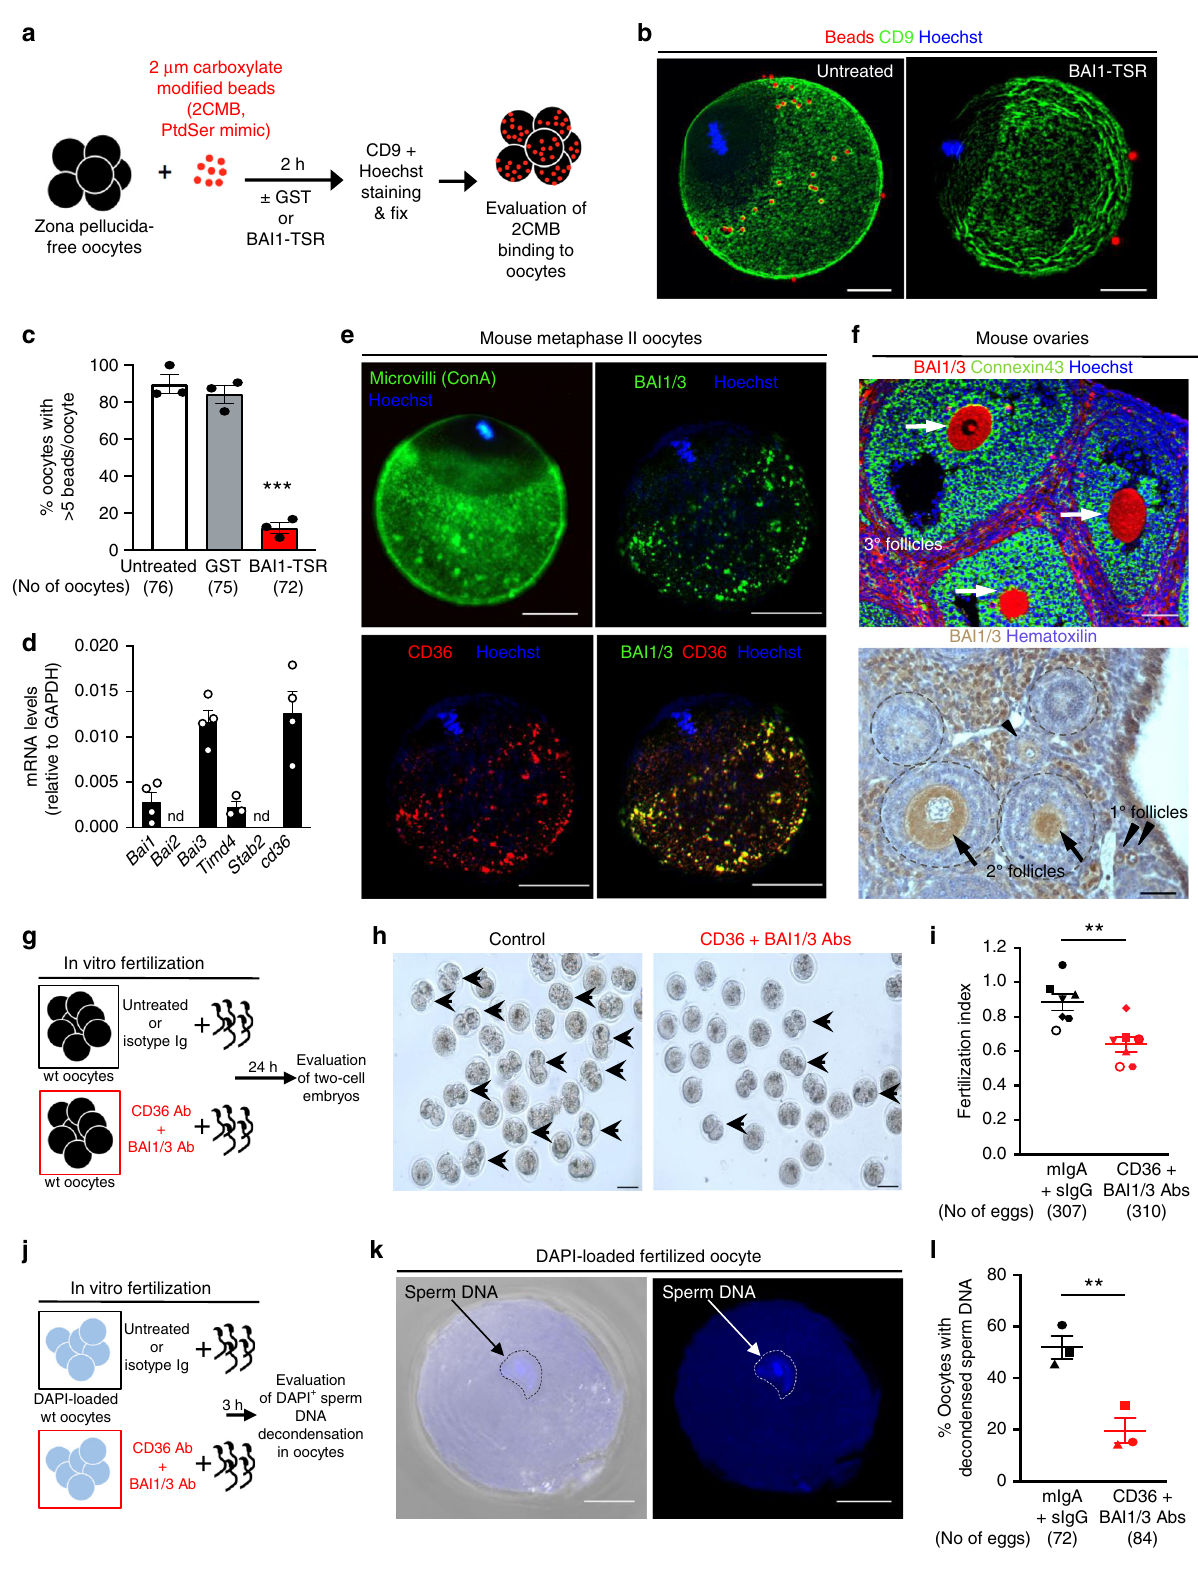
oocytes isolated either from Mertk − / − or Bai1 − / − mice, or mice double de fi cient for both Mertk and Bai1 . Although oocytes isolated from single de fi cient mice (either Mertk − / − or Bai1 − / − ) could be fertilized similar to wild-type eggs (Fig. 3c and Supplementary Fig. 3e), the double de fi cient Mertk − / − Bai1 − / −